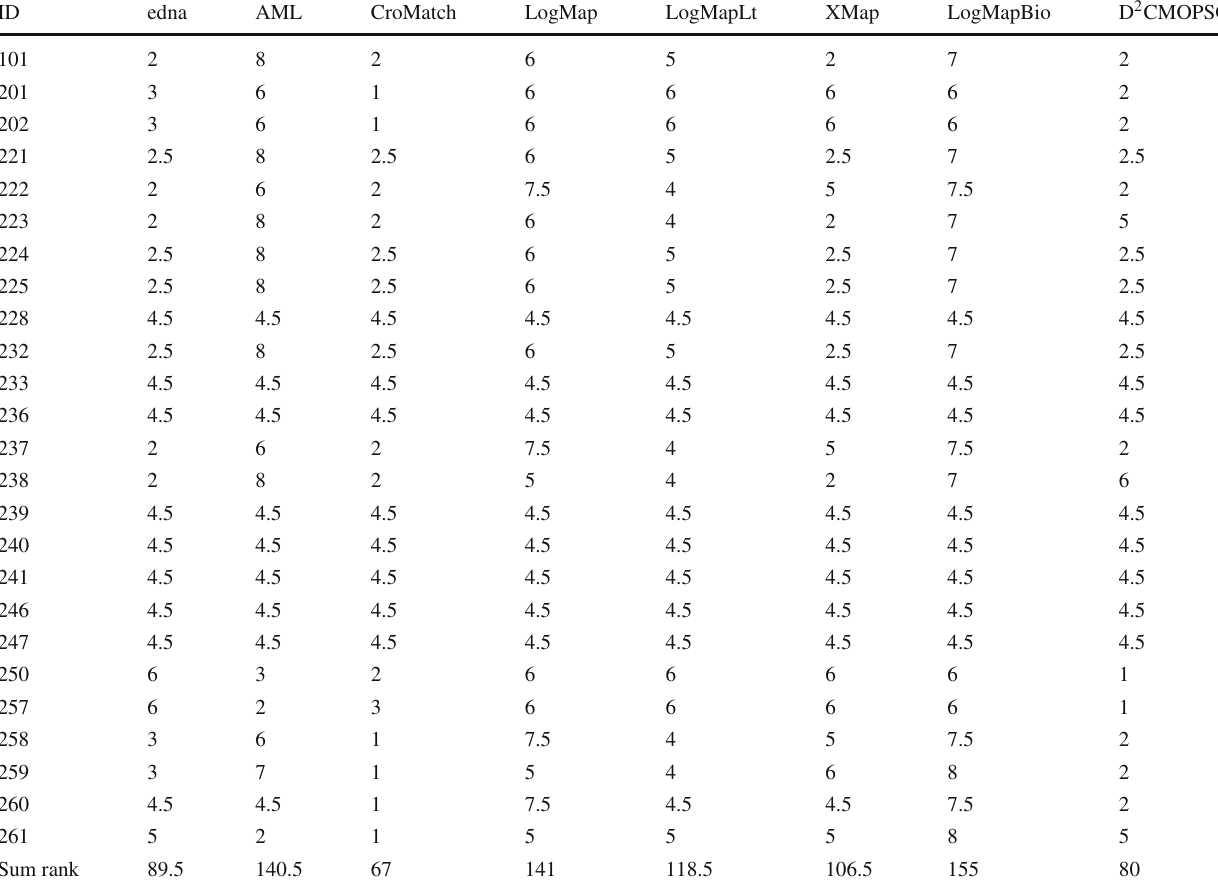
Table 17 Friedman test for recall among D 2 CMOPSO and OAEI’s participants in benchmark